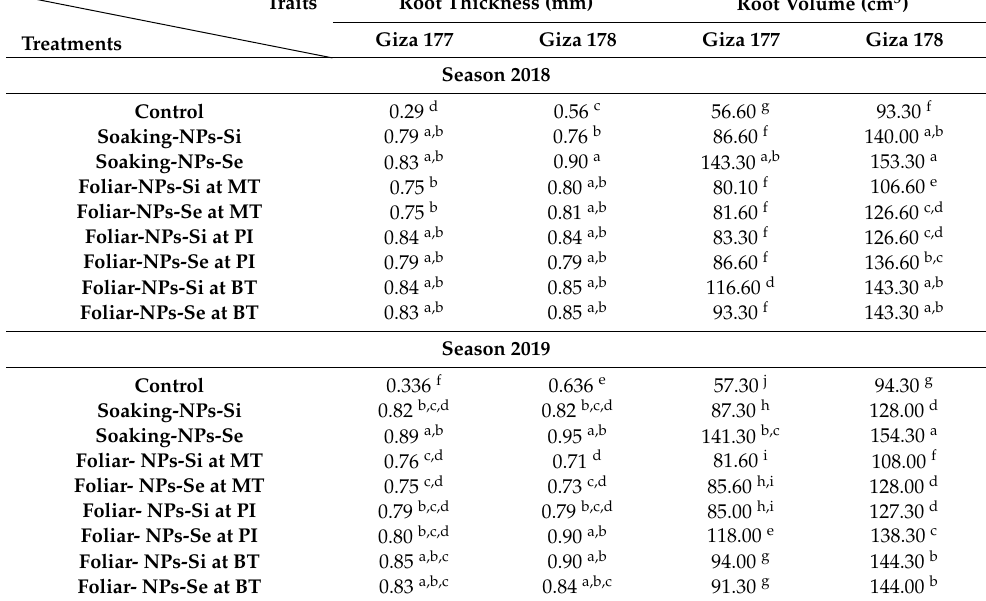
Table 3. Interaction effects of NPs-Si and NPs-Se treatments on root thickness and root volume of the two rice varieties under saline soil